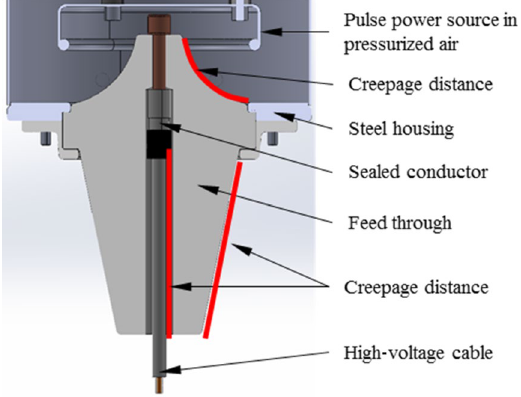
Fig. 18 Electrode samples and arrangements for slot electrodes and formed